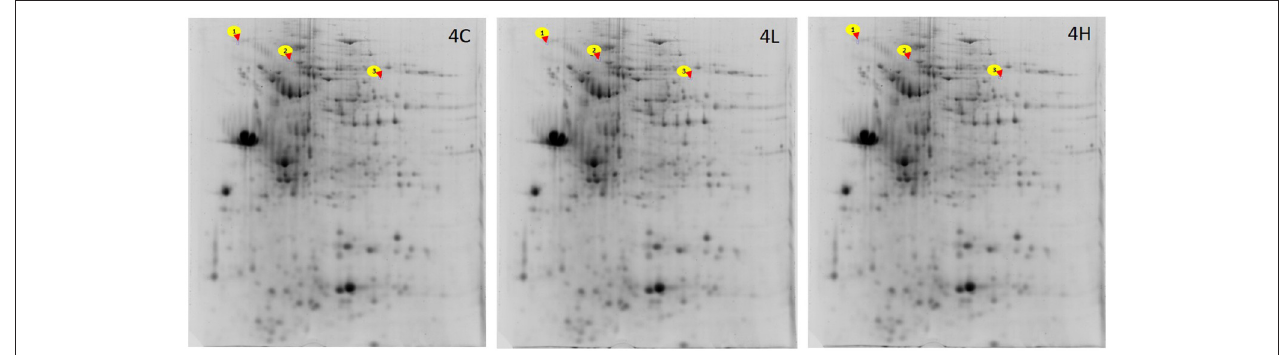
FIGURE 3 | Representative 2-DE gels showing the spots of proteins from the distal intestine of Atlantic salmon. For generating the gels, the intestinal proteins from the distal intestine of Atlantic salmon from the 4C, 4L, and 4H groups were first isoelectrically focused on 17 cm IPG strips (pI 3-10) and then subjected to 12.5% SDS-PAGE. The Sypro®Ruby protein gel stain was used to stain the gels. The spots 1, 2, and 3 corresponds to Ahsg, My11 and Dld, respectively (see Table 6 ). n = 6 tanks, 1 fish/tank.